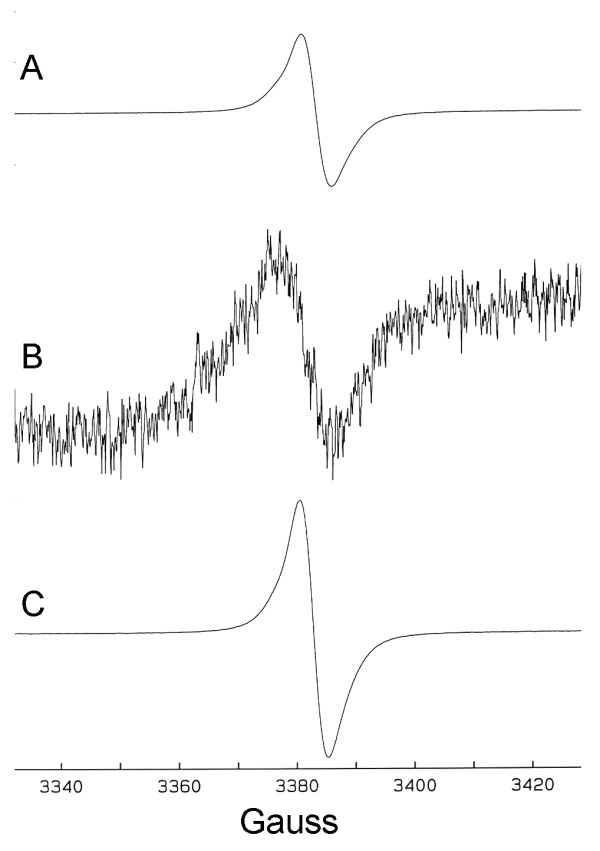
Electron spin resonance spectroscopy on particles collected after treatment with enzymes, denaturant, and hot acid from W. dermatitidis strains A] 8656, B] wdpks1Δ-1, and C] wdpks1Δ-1-501 grown for 10 days in YPD medium at 37°C. The spectra wdpks1Δ-1 is noisy because of the higher amplitude setting used to detect the weaker signal generated by the isolated melanin-like material.